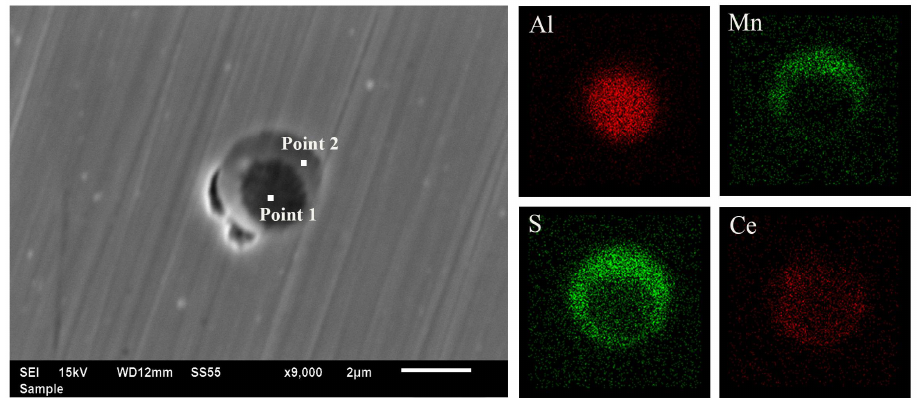
Figure 1. SEM micrograph and EDS mapping images of various elements for typical oxide in 1#.